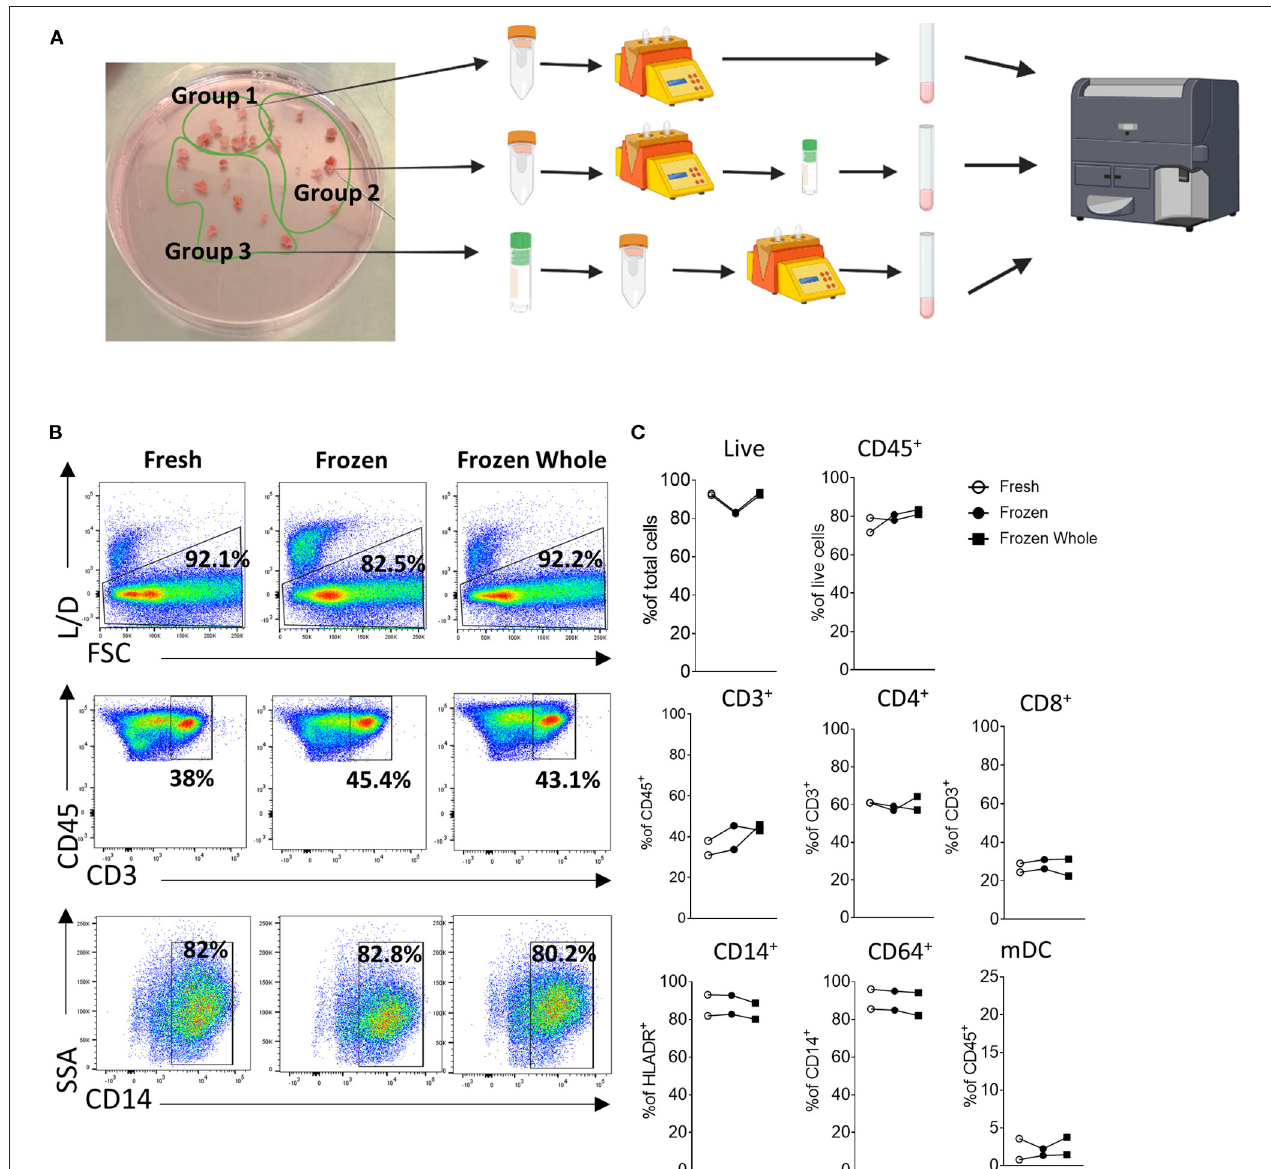
FIGURE 2 | Cryopreservation of synovial tissue biopsies and single cell suspensions. (A) Schematic (Created with BioRender.com). Multiple biopsies from the same patients ( n = 2) were randomly divided them in three groups bearing a similar number of biopsies. Group 1 and 2 synovial tissue biopsies were immediately digested with the enzymatic and mechanical protocol combination to establish a synovial cell suspension as described above. Group 1 (Fresh) was then stained for specific immune cell populations by flow cytometry immediately after digestion. Group 2 (Frozen) was digested and the resulting synovial cell suspension viably frozen in cryovial in a solution of FBS/DMSO 10%. Group 3- whole synovial tissue biopsies were instead viably frozen in FBS/DMSO 10%, prior to digestion and subsequently defrosted and digested. Group 2 and 3 were defrosted on the same day and stained for flow cytometry. (B) Representative dot-plot and (C) frequency of live cells, CD45 + , CD3 + (as frequency of CD45 + cells), CD4 + and CD8 + (as frequency of CD3 + cells), CD14 + cells (as frequency of HLADR + cells), CD68 + (as frequency of CD14 + cells) and mDC (as frequency of CD45 +